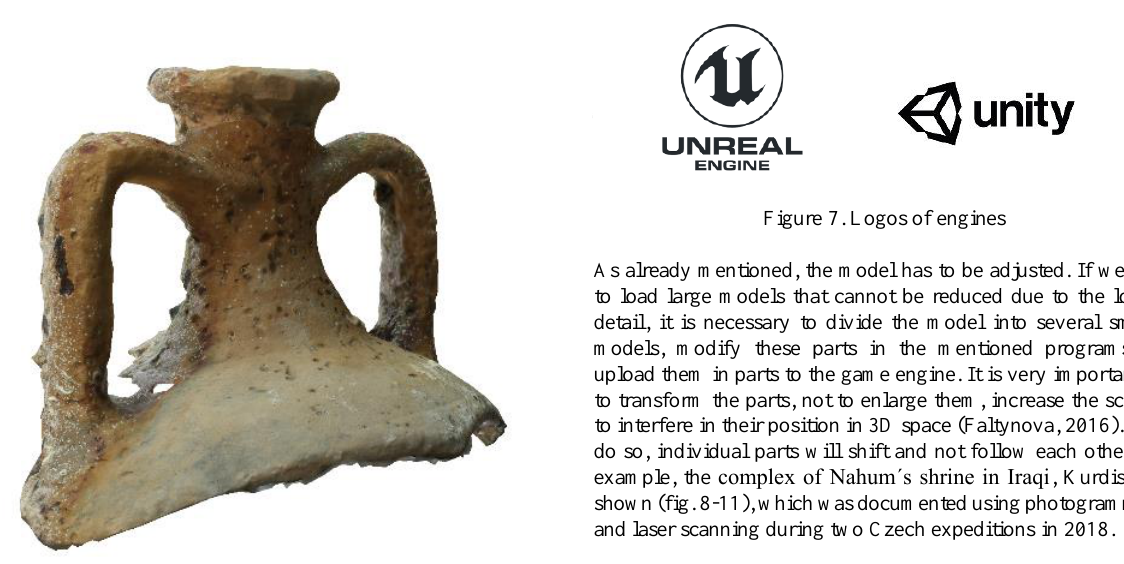
Figure 5. 10,000 model with 4k texture